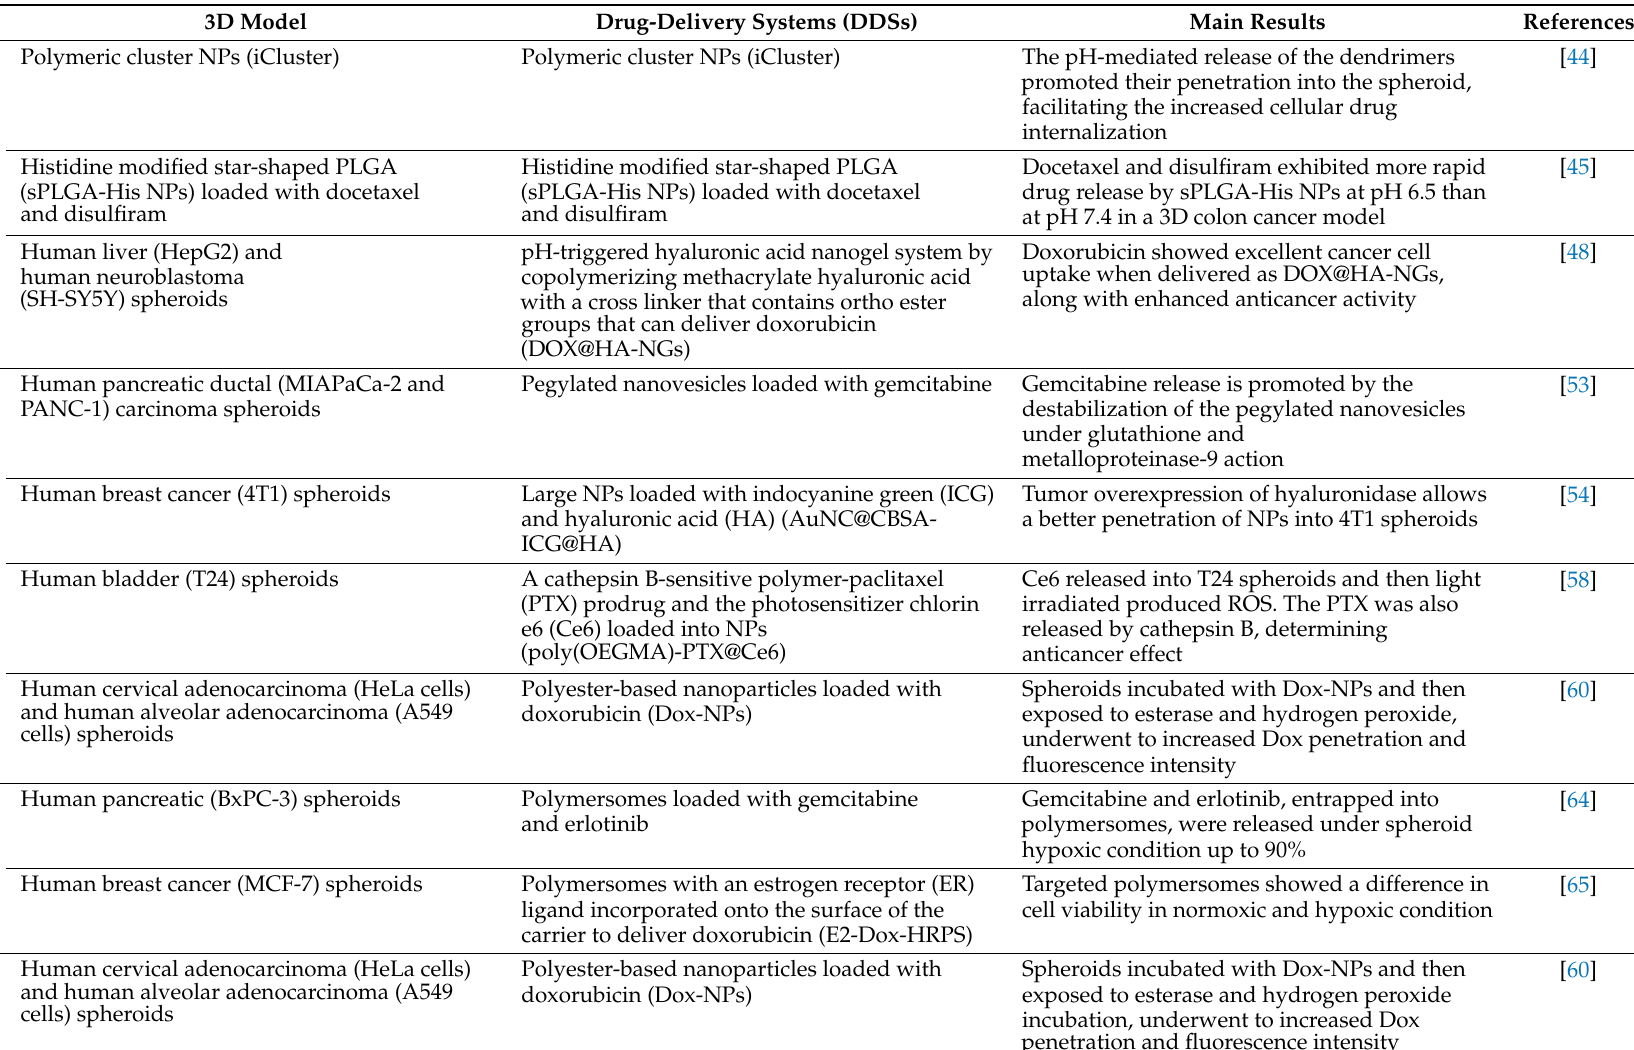
Table 2. Endogenous stimuli-responsive DDSs in 3D cancer